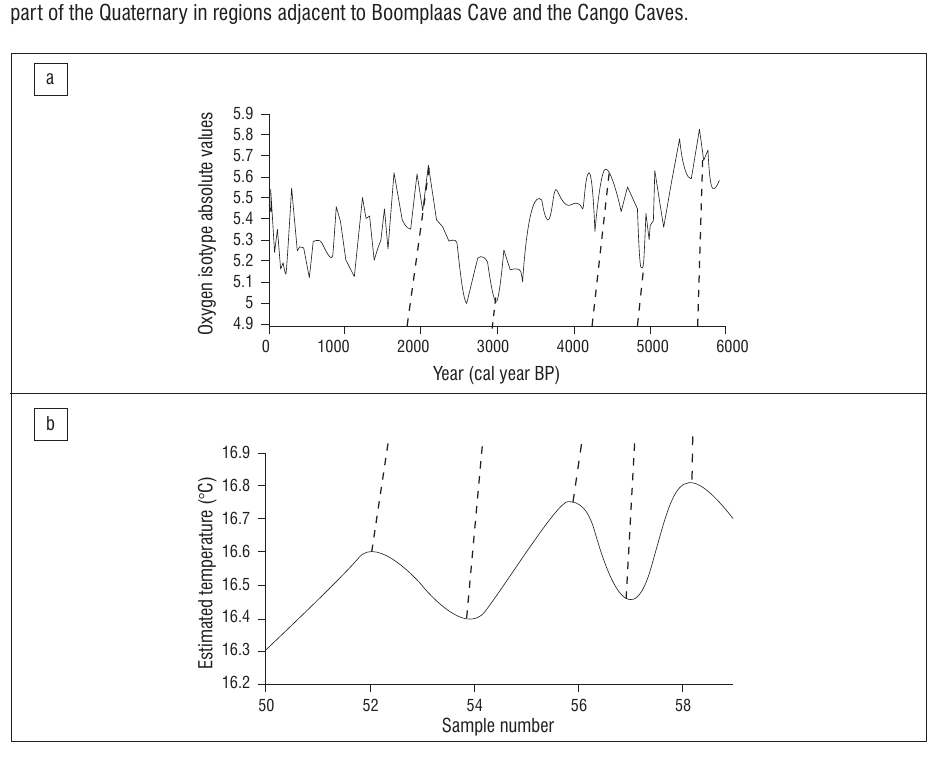
Figure 1: (a) Raw oxygen isotope data from a speleothem in the Cango Caves, obtained by Talma and Vogel 4 with cali brated radiocarbon dates within the past 6000 years. Data were provided for this study by Talma. (b) Holocene mean annual temperature curve for samples 50–59 from Boomplaas Cave, as calculated by Thackeray 5 . These Holocene samples are dated between circa 1000 and 6000 BP (see radiocarbon dates in Table 1). The two curves appear to be correlated (dashed